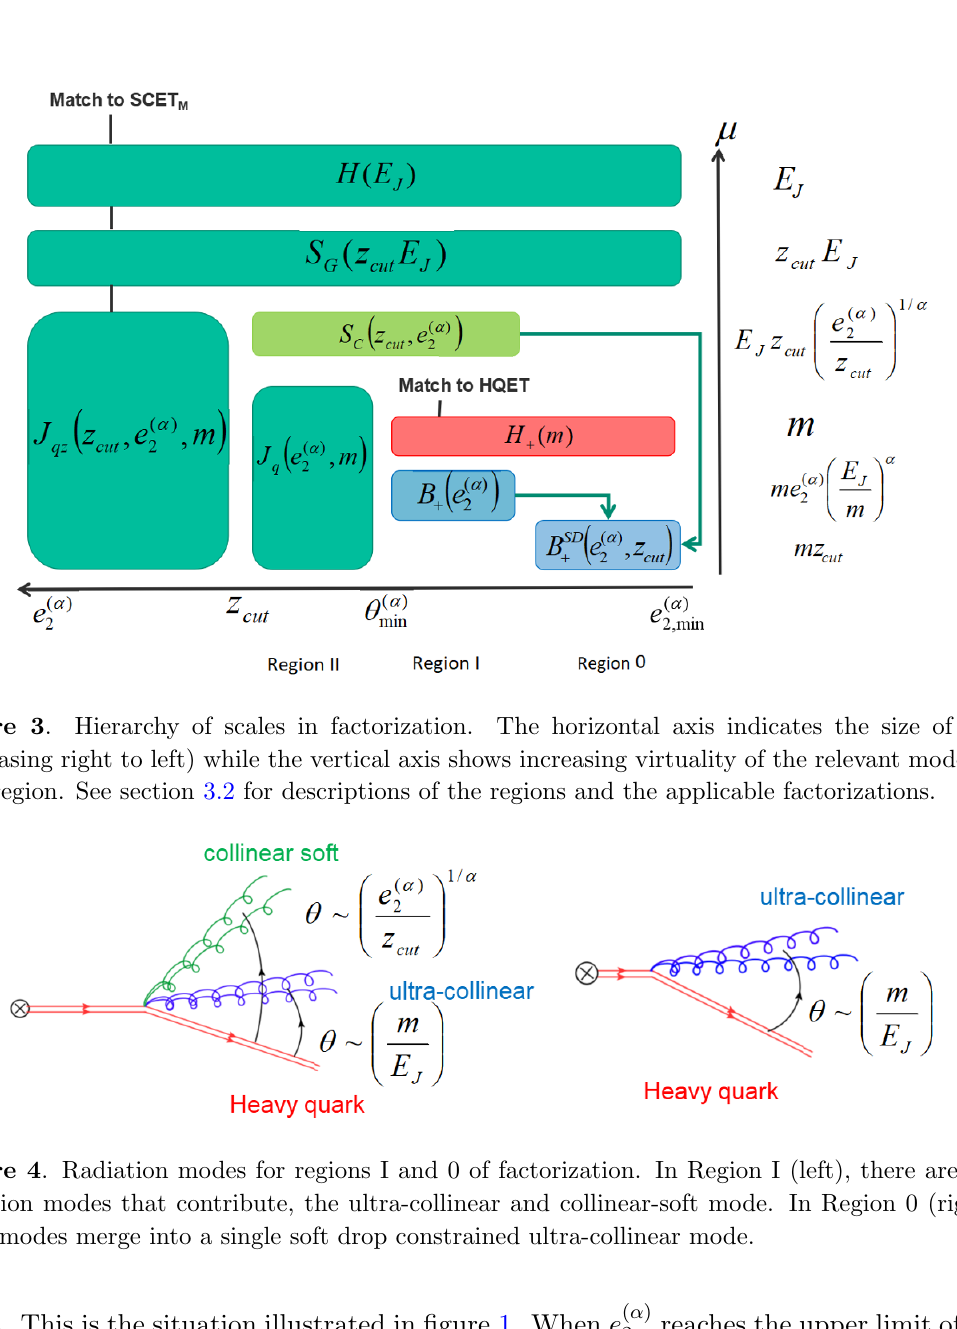
Figure 4 . Radiation modes for regions I and 0 of factorization. In Region I (left), there are two radiation modes that contribute, the ultra-collinear and collinear-soft mode. In Region 0 (right), these modes merge into a single soft drop constrained ultra-collinear